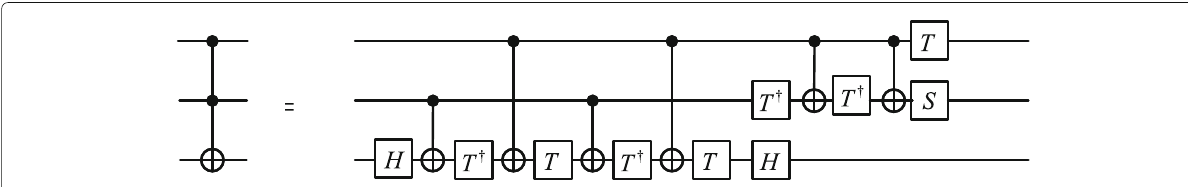
Fig. 3 The decomposition of Toffoli gate in (Nielsen and Chuang 2001)